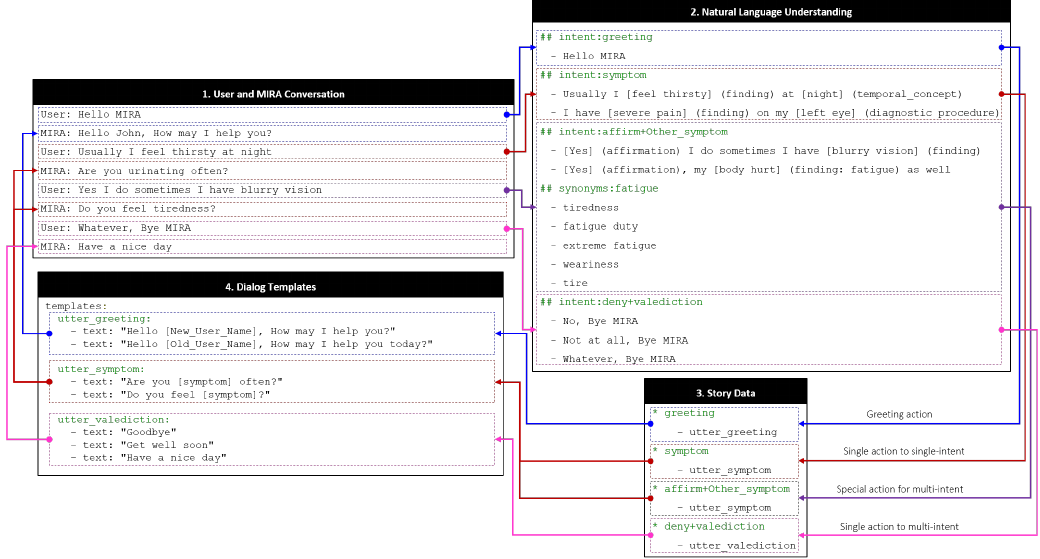
Figure 4. MIRA implementation model for conversational